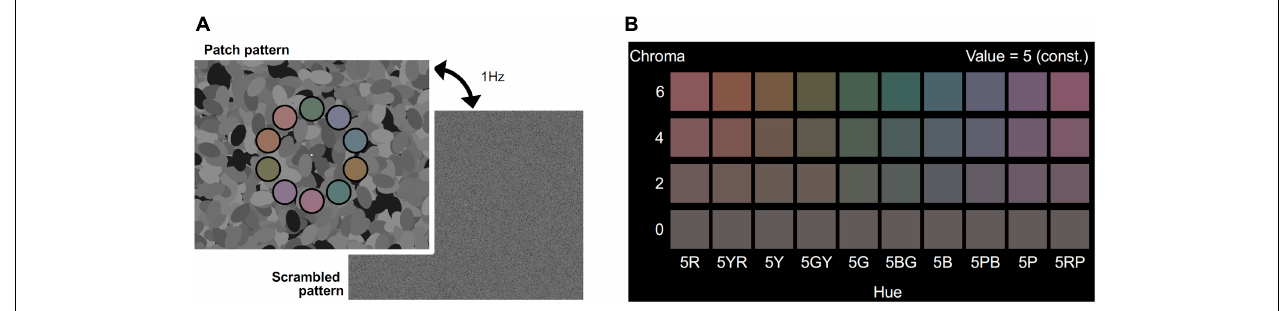
FIGURE 1 | (A) Visual stimuli for the fMRI experiment. Visual stimuli alternating at 1 Hz between the patch pattern (top) and the scrambled pattern (bottom) was presented in the stimulation phase of the fMRI experiment. Colors of the 10 patches had the same Chroma (/6, /4, /2, or /0) and Value (5/) of Munsell color system. Achromatic ellipses in the background had one of eight luminance levels (from 0.3 to 30.4 cd/m 2 ). Scrambled patterns were generated by randomly shuffling the coordinates of pixels in the patch patterns. The fixation point was set at the center of the screen. (B) Set of colors for patches in the four Chroma conditions. Chroma value of each visual stimulus was either /6 (Top raw), /4 (second raw), /2 (third raw), or /0 (bottom raw). All patches had the same gray color in Chroma /0